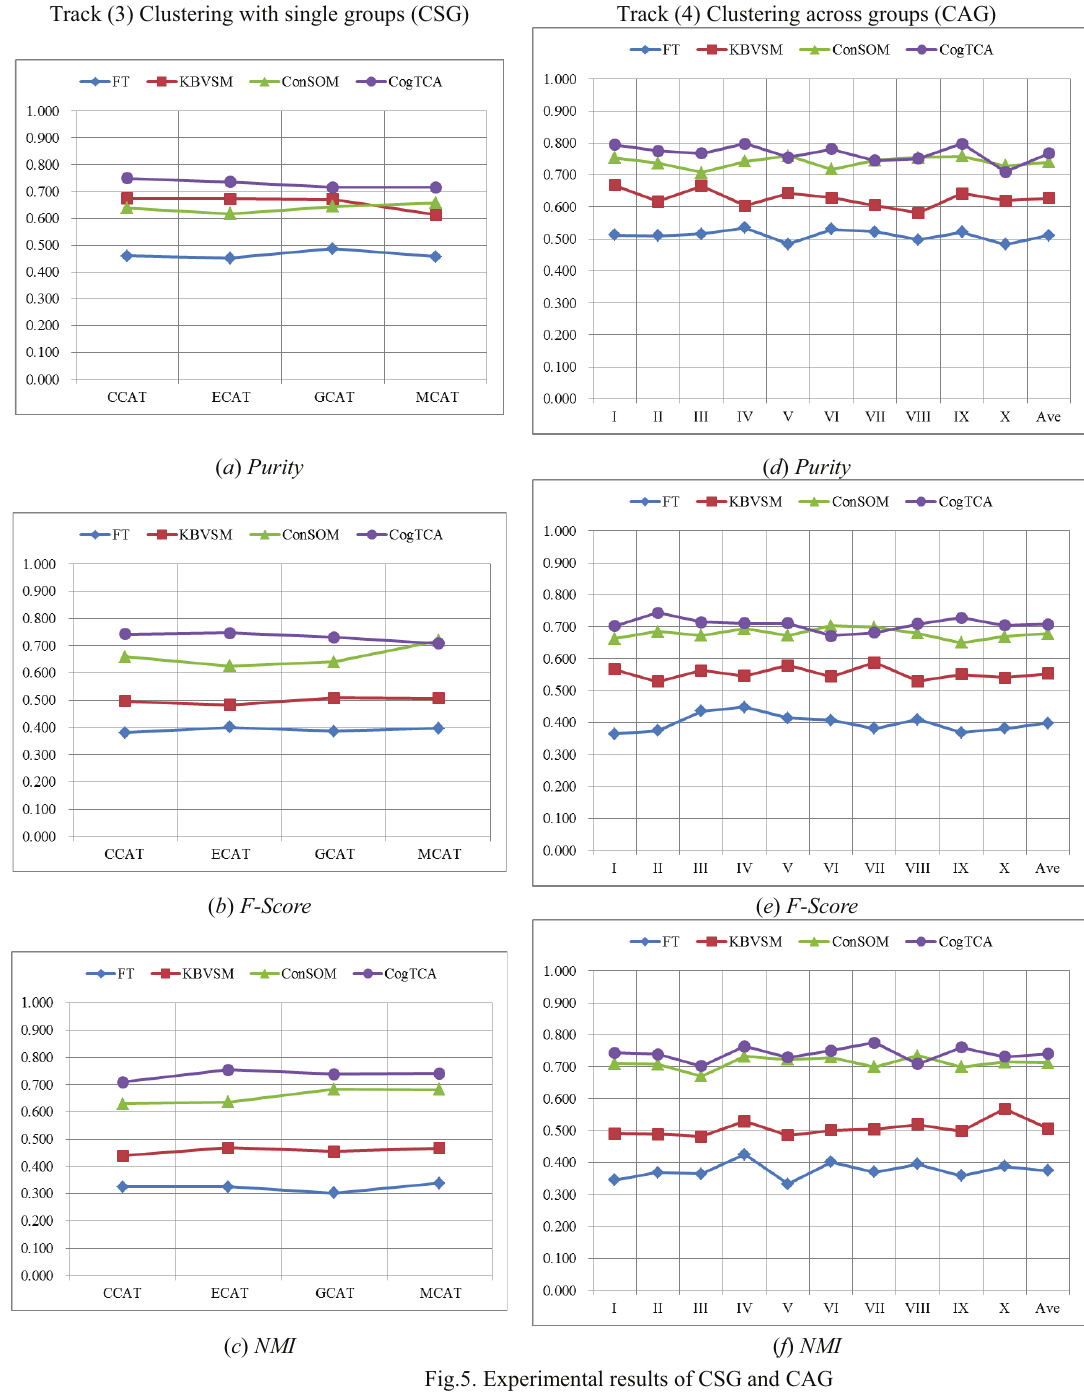
Fig.5. Experimental results of CSG and